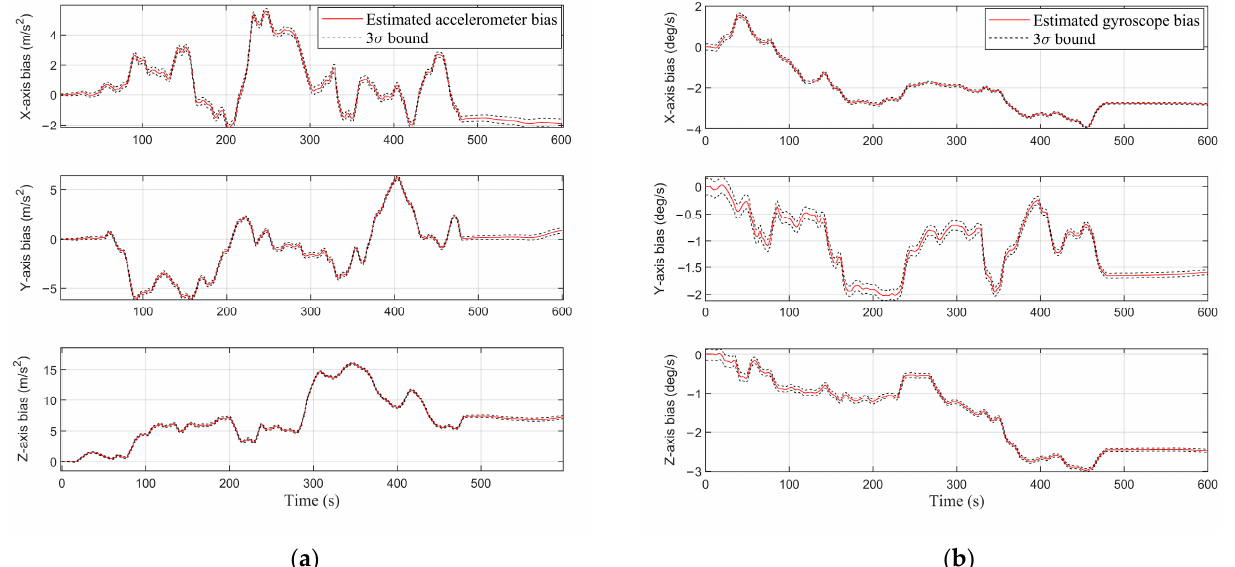
Figure 17. ( a ) Estimated accelerometer bias, and ( b ) Estimated gyroscope bias with ±3𝜎 bound.